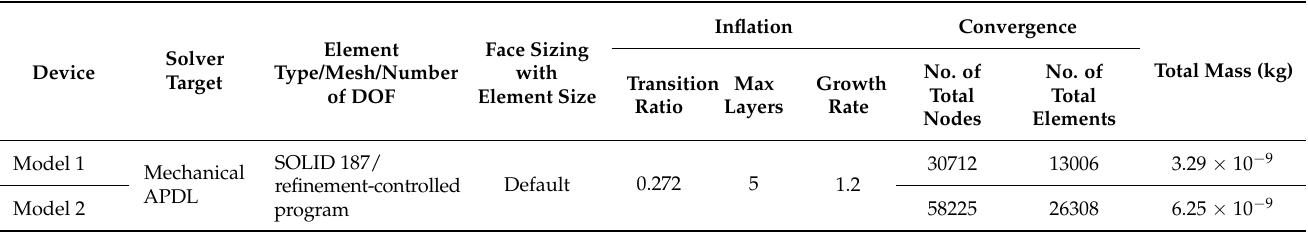
Table 9. Technical details about FEA in Ansys Workbench for Models 1 and 2 of microgrippers.